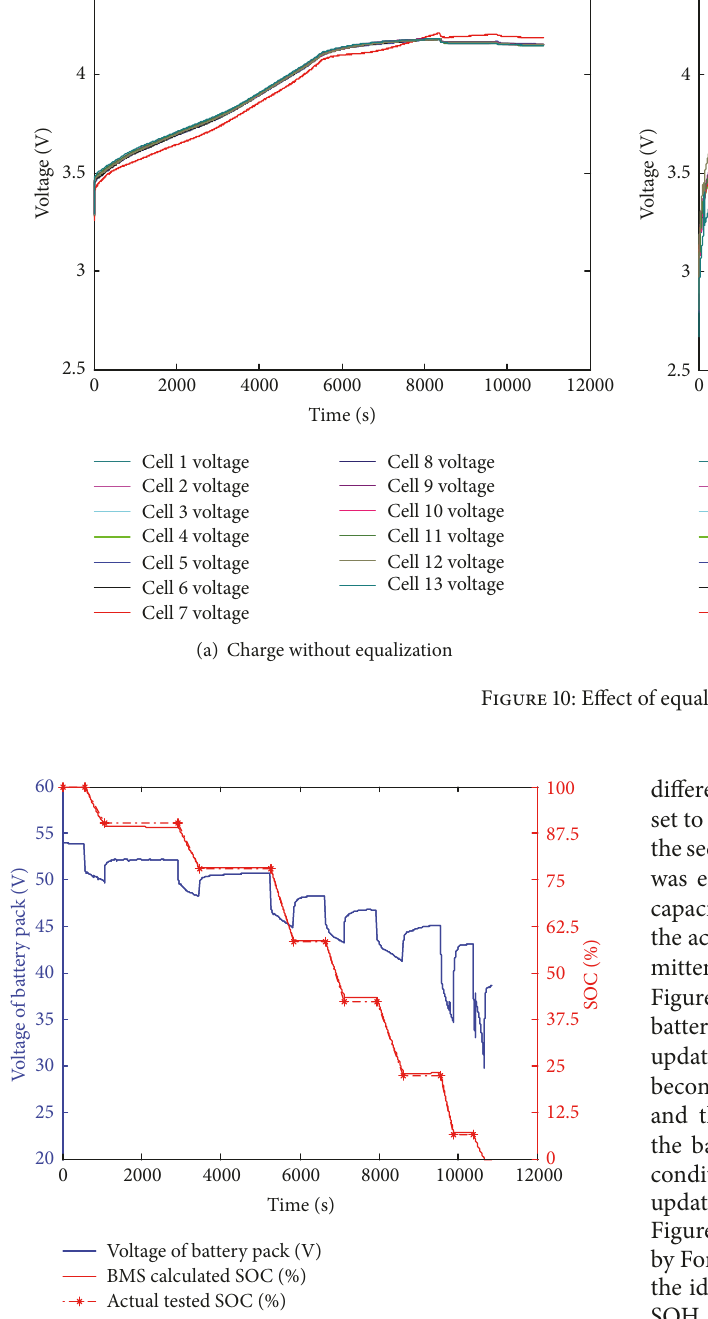
Figure 11: SOC comparison between the calculated and the esti-